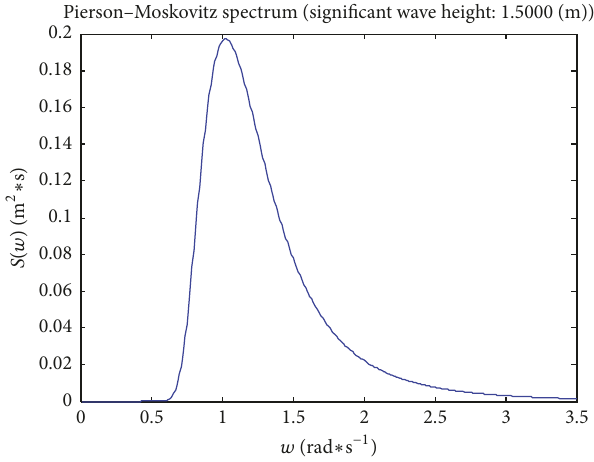
Figure 2: Pierson–Moskovitz wave spectrum for 𝐻 1/3 = 1.5 [ m ] .